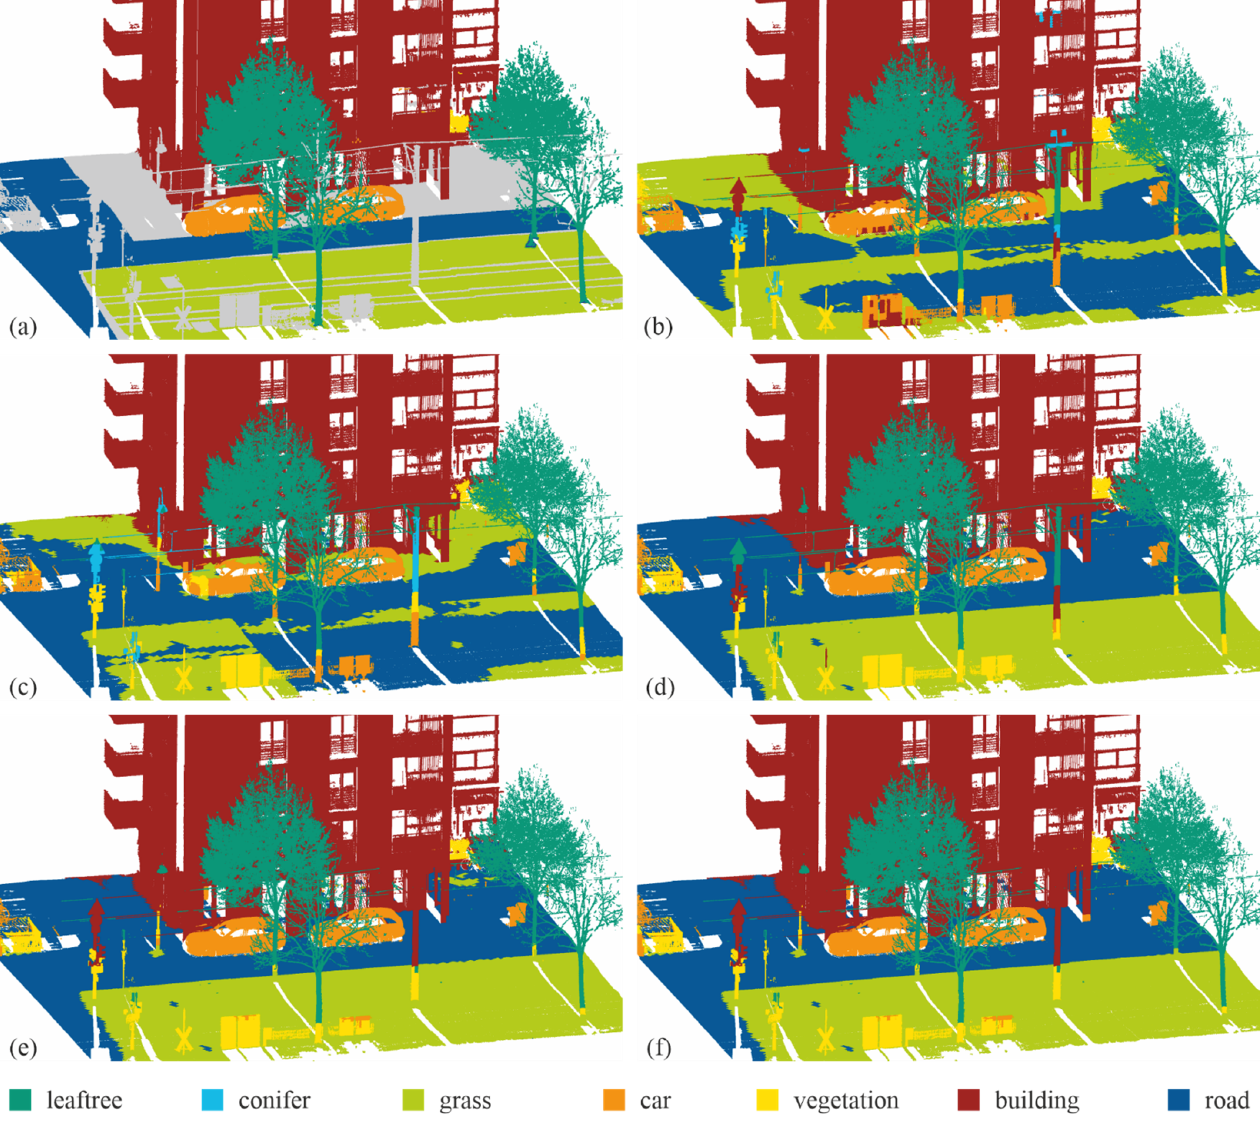
Figure 6. Exemplary semantics shown on the point cloud section from Figure 3. ( a ) Manually labeled point cloud section used as ground truth. ( b ) Classification results using only geometry. ( c ) Classification results using geometry and intensity. ( d ) Classification results using geometry and DAV. ( e ) Classification results using geometry, intensity and DAV. ( f ) Classification results using geometry, intensity, DAV and number of points per voxel.